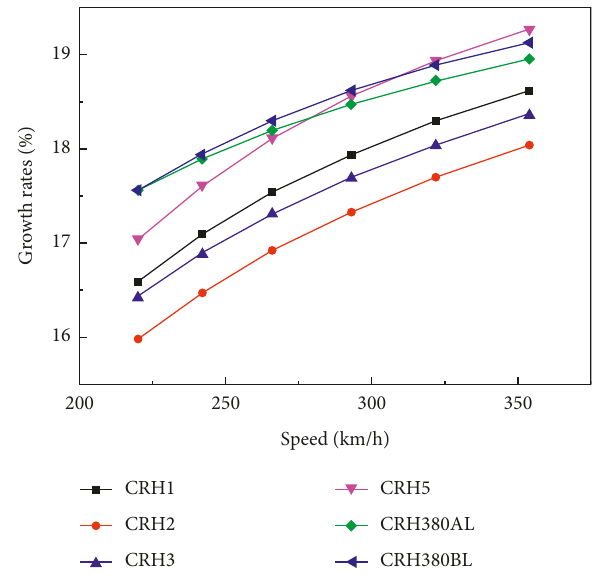
Figure 3: Energy consumption growth rate per 100 seat-kilometers of each EMU model (%) as the speed increases at 10% increment. Table 5: Slope data of downhill lines between K2363 +755 and K2373 +355 (the slope data of uphill lines are the opposite).